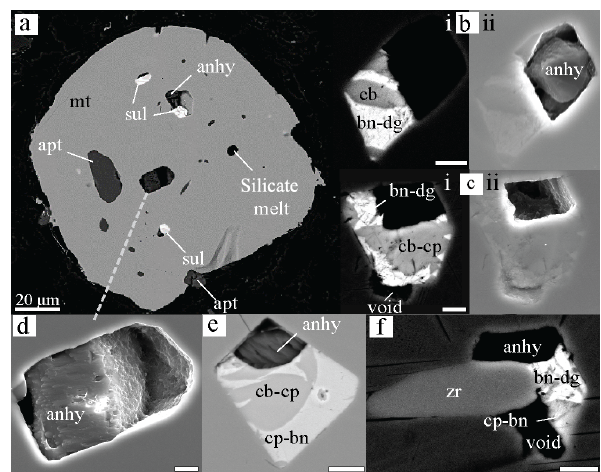
Figure 6. BSE (a, b-i, c-i, e, f) and SE (b-ii, c-ii, d, e) micropho- tographs of anhydrite occurrences in magnetite phenocrysts, as in- dividual phases or found together with Cu-rich sulfides and occa- sionally with zircons. Apatite and silicate melts are often hosted by the same magnetite phenocrysts as well. Note that the anhydrite (b- i, f) in BSE is not visible unless seen in SE (b-ii) ; it can be partly (d, e) or completely (c) dissolved. In panel (e) BSE and SE imagining have been merged in order to make both sulfide and sulfate, respec- tively, visible. For abbreviations, see the legend in Fig. 4. The scale bar corresponds to 2µm unless stated